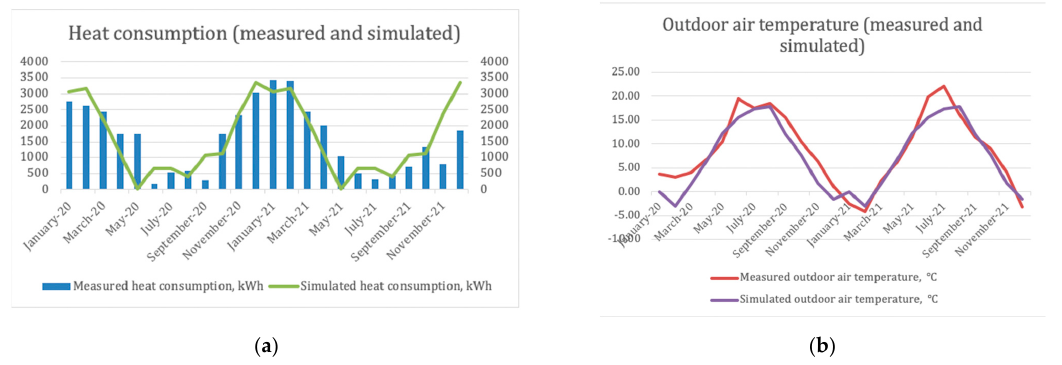
Figure 6. ( a ) Measured and simulated heat consumption for Scenario 1B; ( b ) measured and simulated outdoor air temperature. Table 3. Energy consumption and costs for different scenarios.